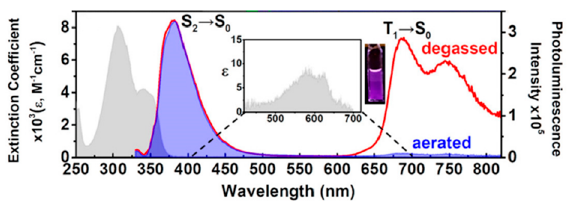
Scheme 30. Chemical structure of compound 93 .